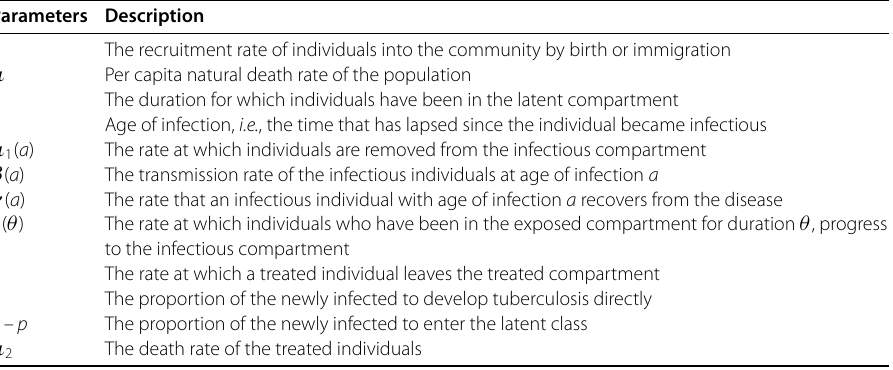
Table 1 The definition of the parameters in system (1.4) Parameters